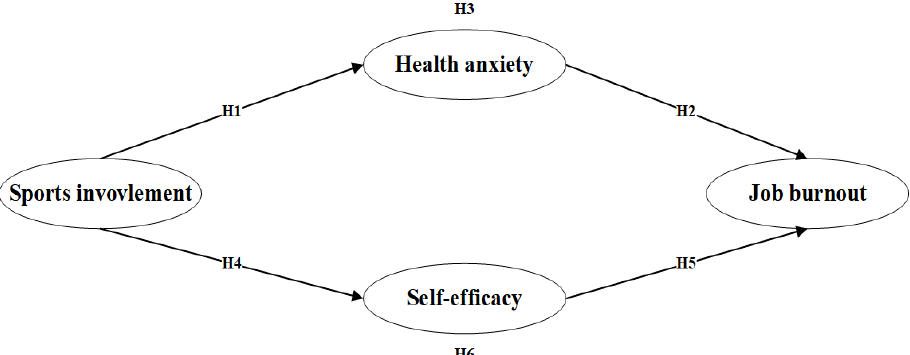
Figure 1. The hypothesized model.